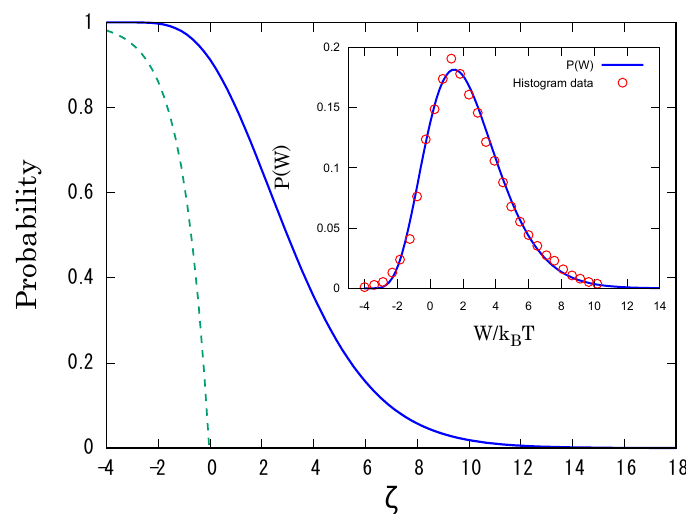
Figure 2. The plot data in the inset shows the work distribution constructed from the measured histogram by the experiment of Ref. [7] and the solid line shows the nonlinear least-squares fit to the gamma distribution Equation (8). The solid blue line indicates the probability P ( W ≥ ζ ) represented by the lower incomplete gamma function Equation (9). The dashed line indicates the lower bound by Equation (6). The values β ∆ F = − 0.03 and β W max = 18.0 are used for the calculations of the bound